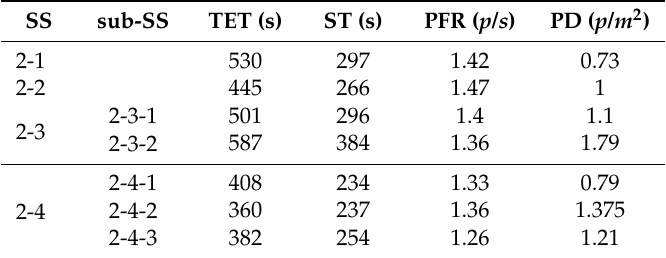
Table 3. The evacuation efficiency and risk state of toilets in the SS